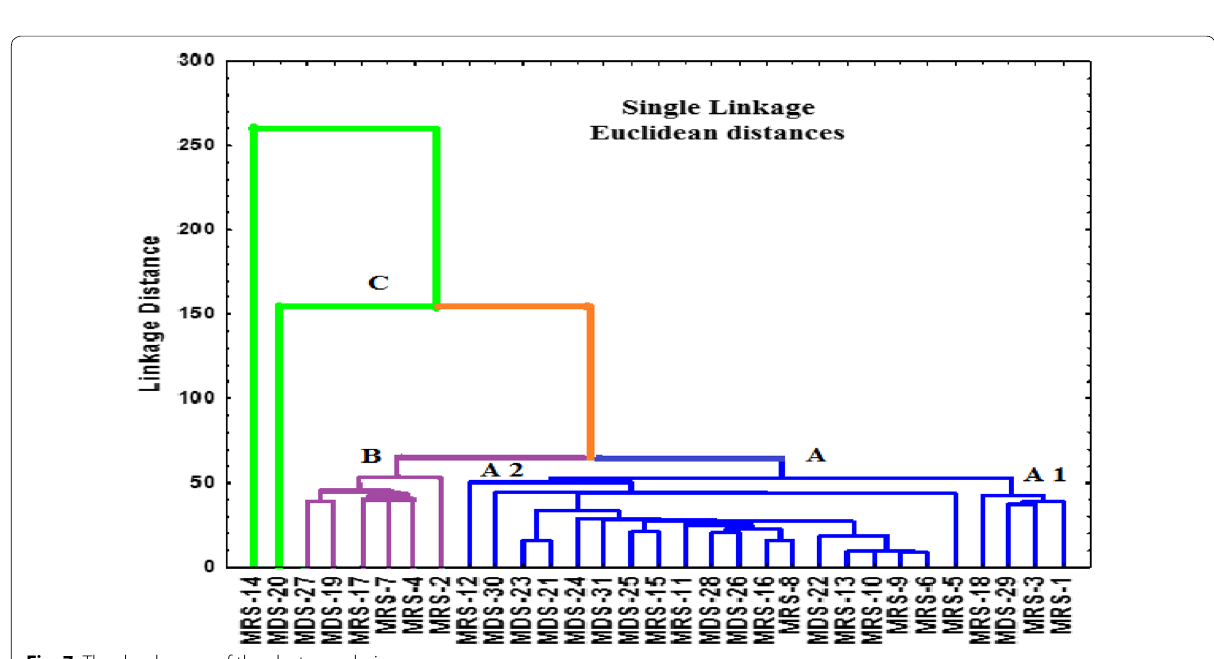
Fig. 7 The dendogram of the cluster analysis